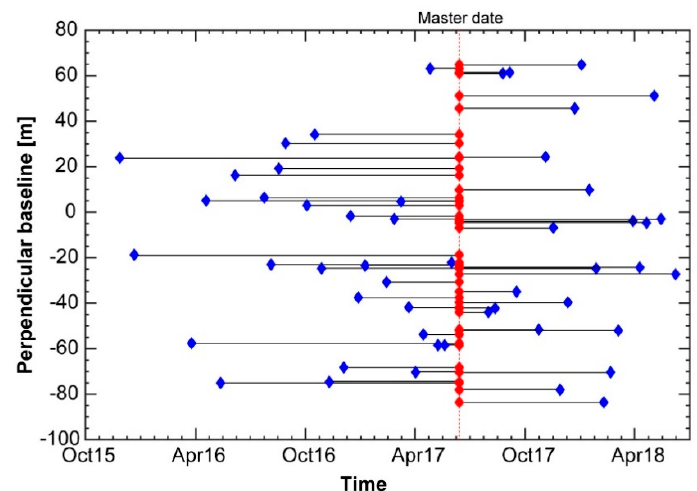
Figure 3. Perpendicular and temporal baselines of interferograms. Red diamonds indicate the master image, blue diamonds represent slave images and black lines represent interferograms formed from the master image and corresponding slave images.